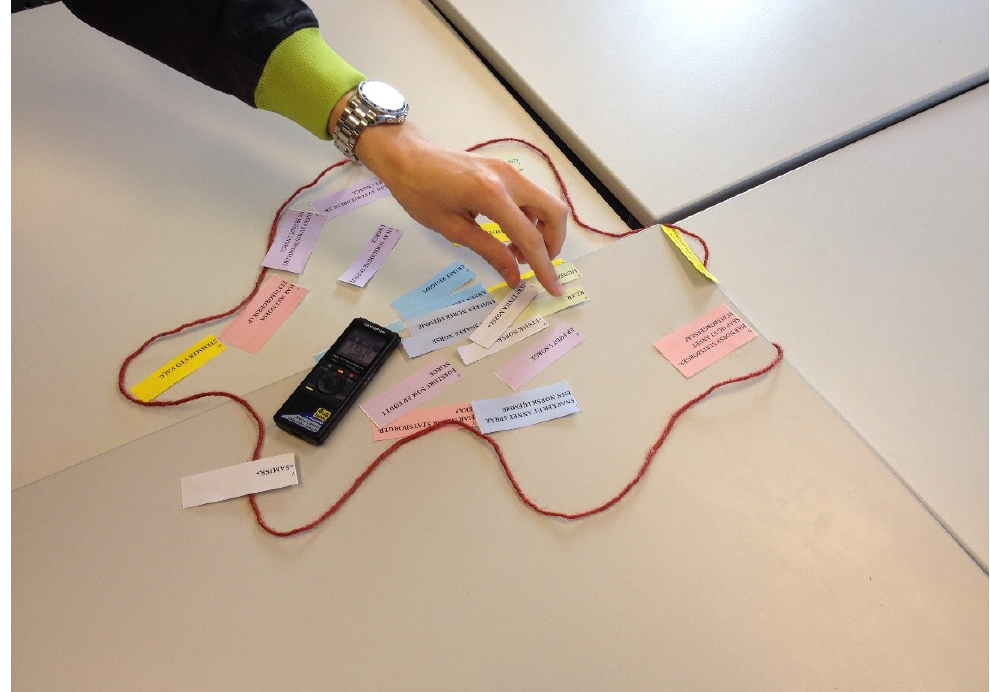
Photo 1: Example from one of the focus groups: pupils discuss the placement of dimensions of Norwegianness, within and outside an imperfect boundary (red thread